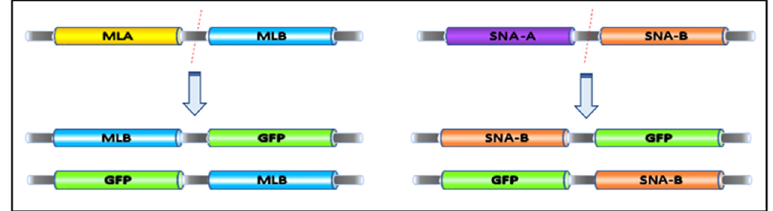
Figure 4. Schematic diagram of MLB-GFP and SNA-B-GFP fusion constructs.